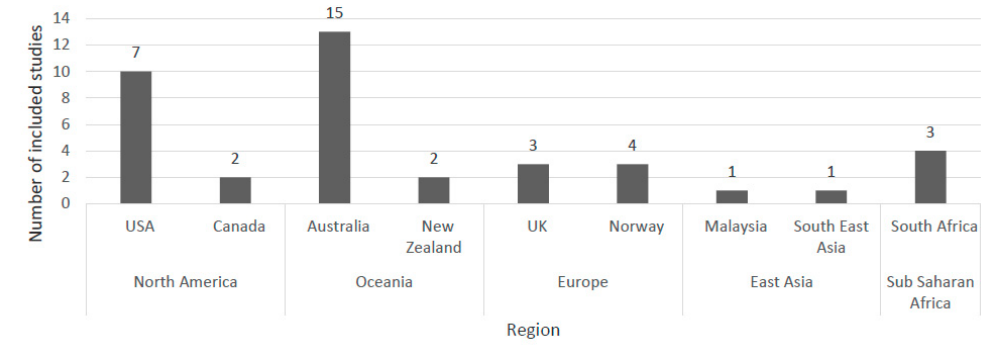
Figure 2. Study characteristics of the articles identified in the review.